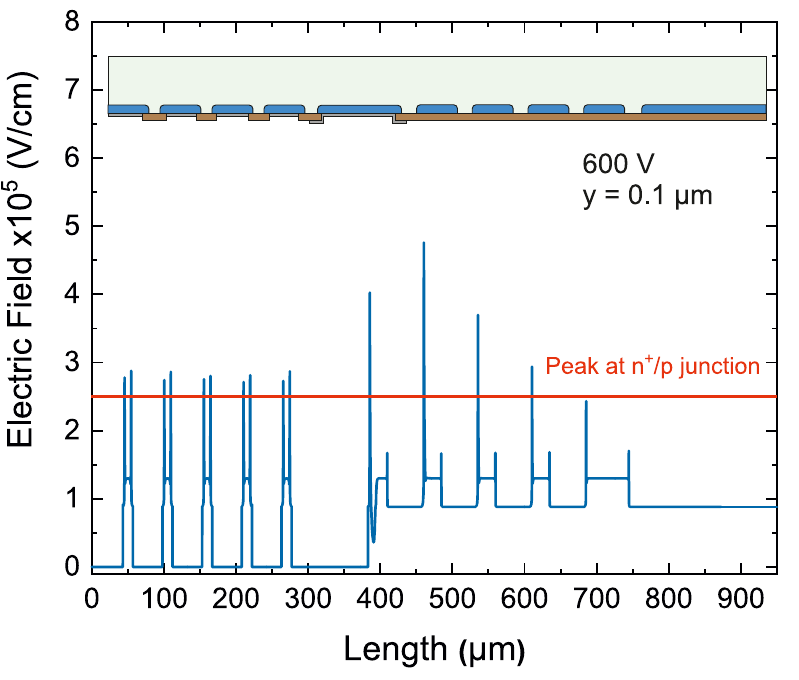
Figure 5. Electric field across the length of the iLGAD. Peaks at the periphery are higher than the maximum peak at the main junction. The conductive electron layer created by the X-rays causes these